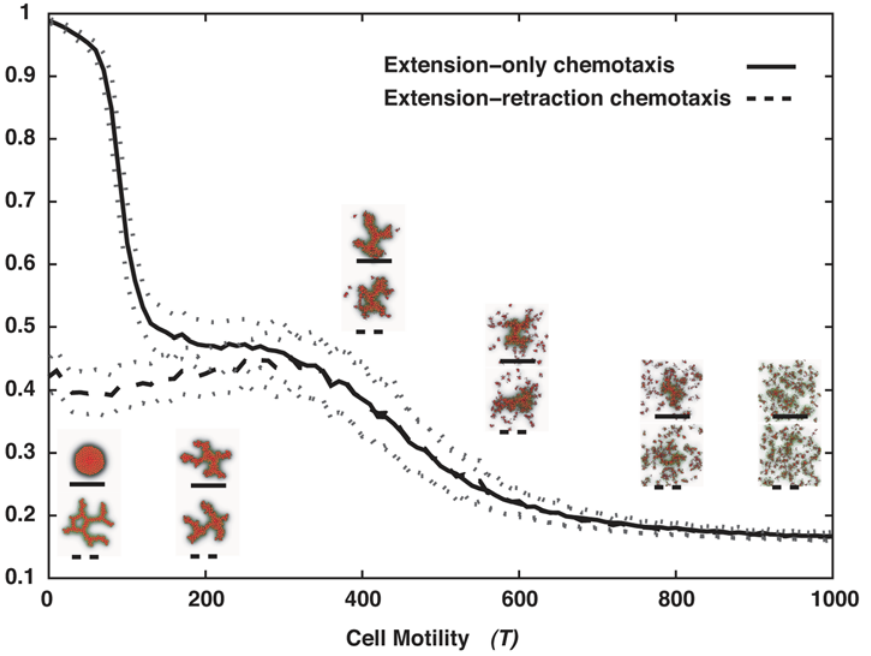
Figure 11. Compactness ( C = A cluster / A hull ) of 128-cell clusters on 400 6 400-pixel lattices ( , 400 m m 6 400 m m) after 5,000 MCS ( , 40 h) as a function of the cell motility T , for standard Savill–Hogeweg [ 36 ] extension–retraction chemotaxis (solid curve), and for extension- only chemotaxis (dashed curve). Black curves show the mean over 100 simulations for each T (with a T -increment of 10). Dotted grey curves indicate one standard deviation. Insets: Representative configurations after 5,000 MCS ( , 40 h).